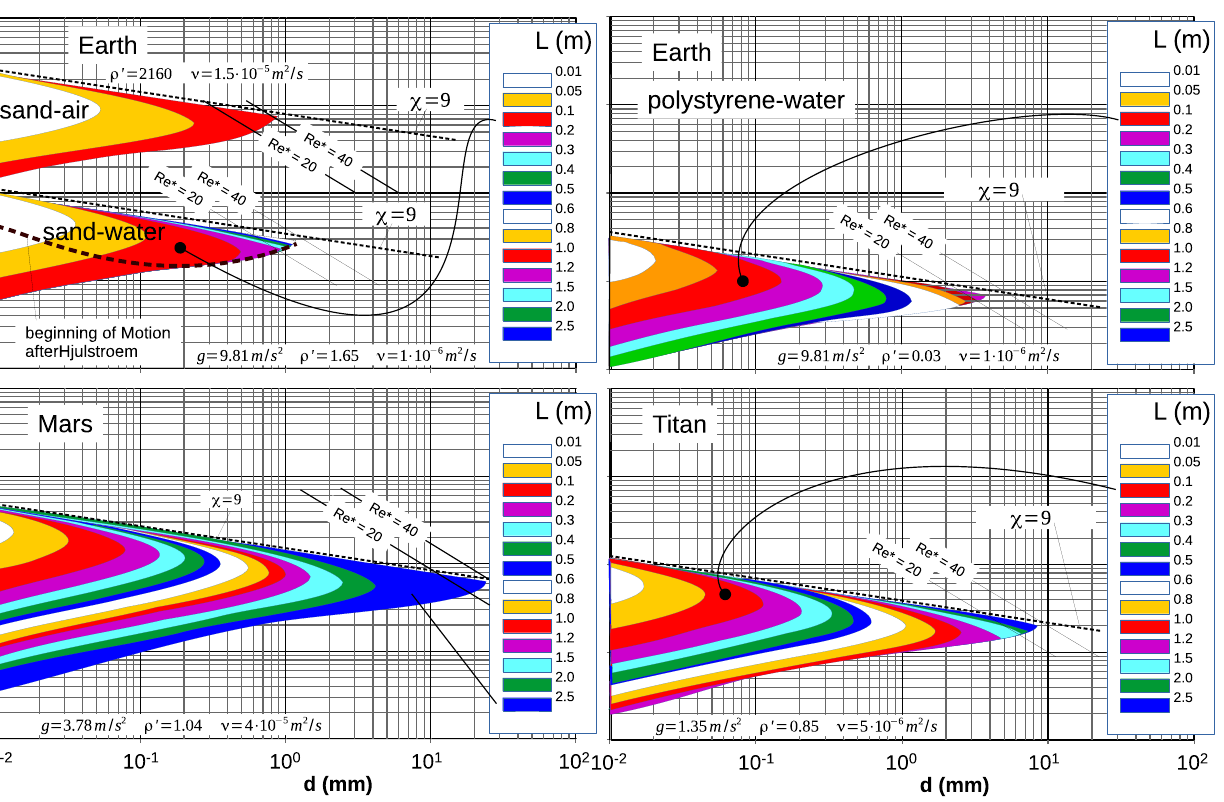
Figure 16. Predicted length of ripples on Earth, Mars, and Titan based on the theory presented here, assuming a completely cohesion-free sediment. Upper row: Earth with sand-water and sand-air (left) and polystyrene-water (right). The dashed curve in the sand-water case shows the effect of sediments with some parts of cohesives on the beginning of motion, analogous to the well-known Hjulström curve. Lower row: Mars (martian sands driven by highly concentrated brines, left) and Titan (ice grains driven by liquid methane flows